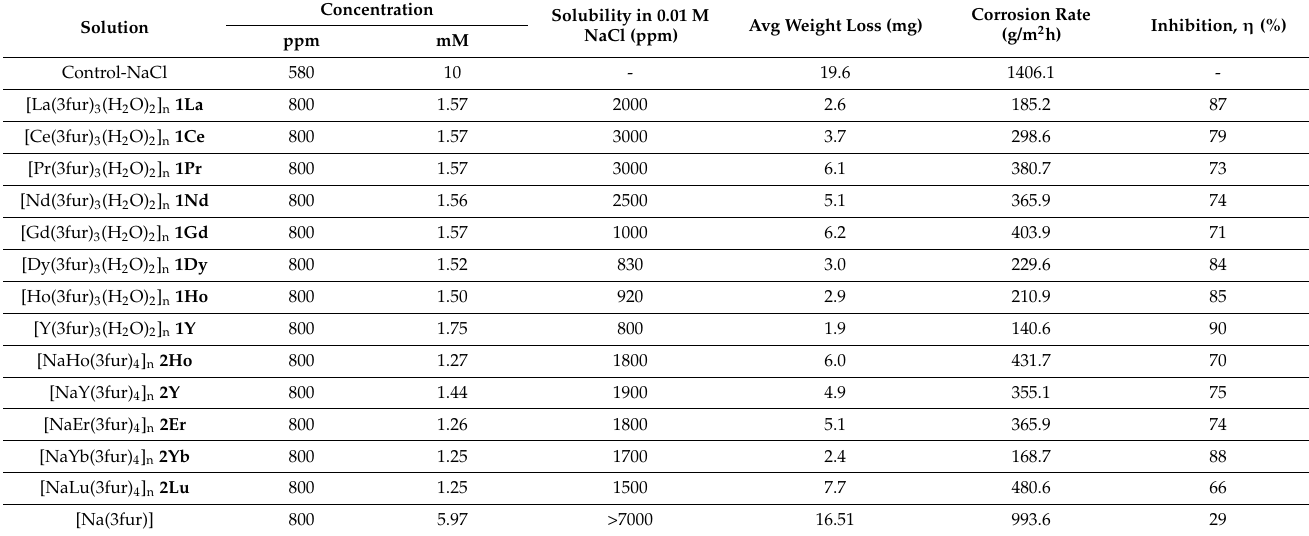
Table 2. Observed weight loss, corrosion rates (g/m 2 h) and percentage inhibition ( η ) for mild steel coupons immersed in specific solutions at 800 ppm concentrations in 0.01 M NaCl for seven